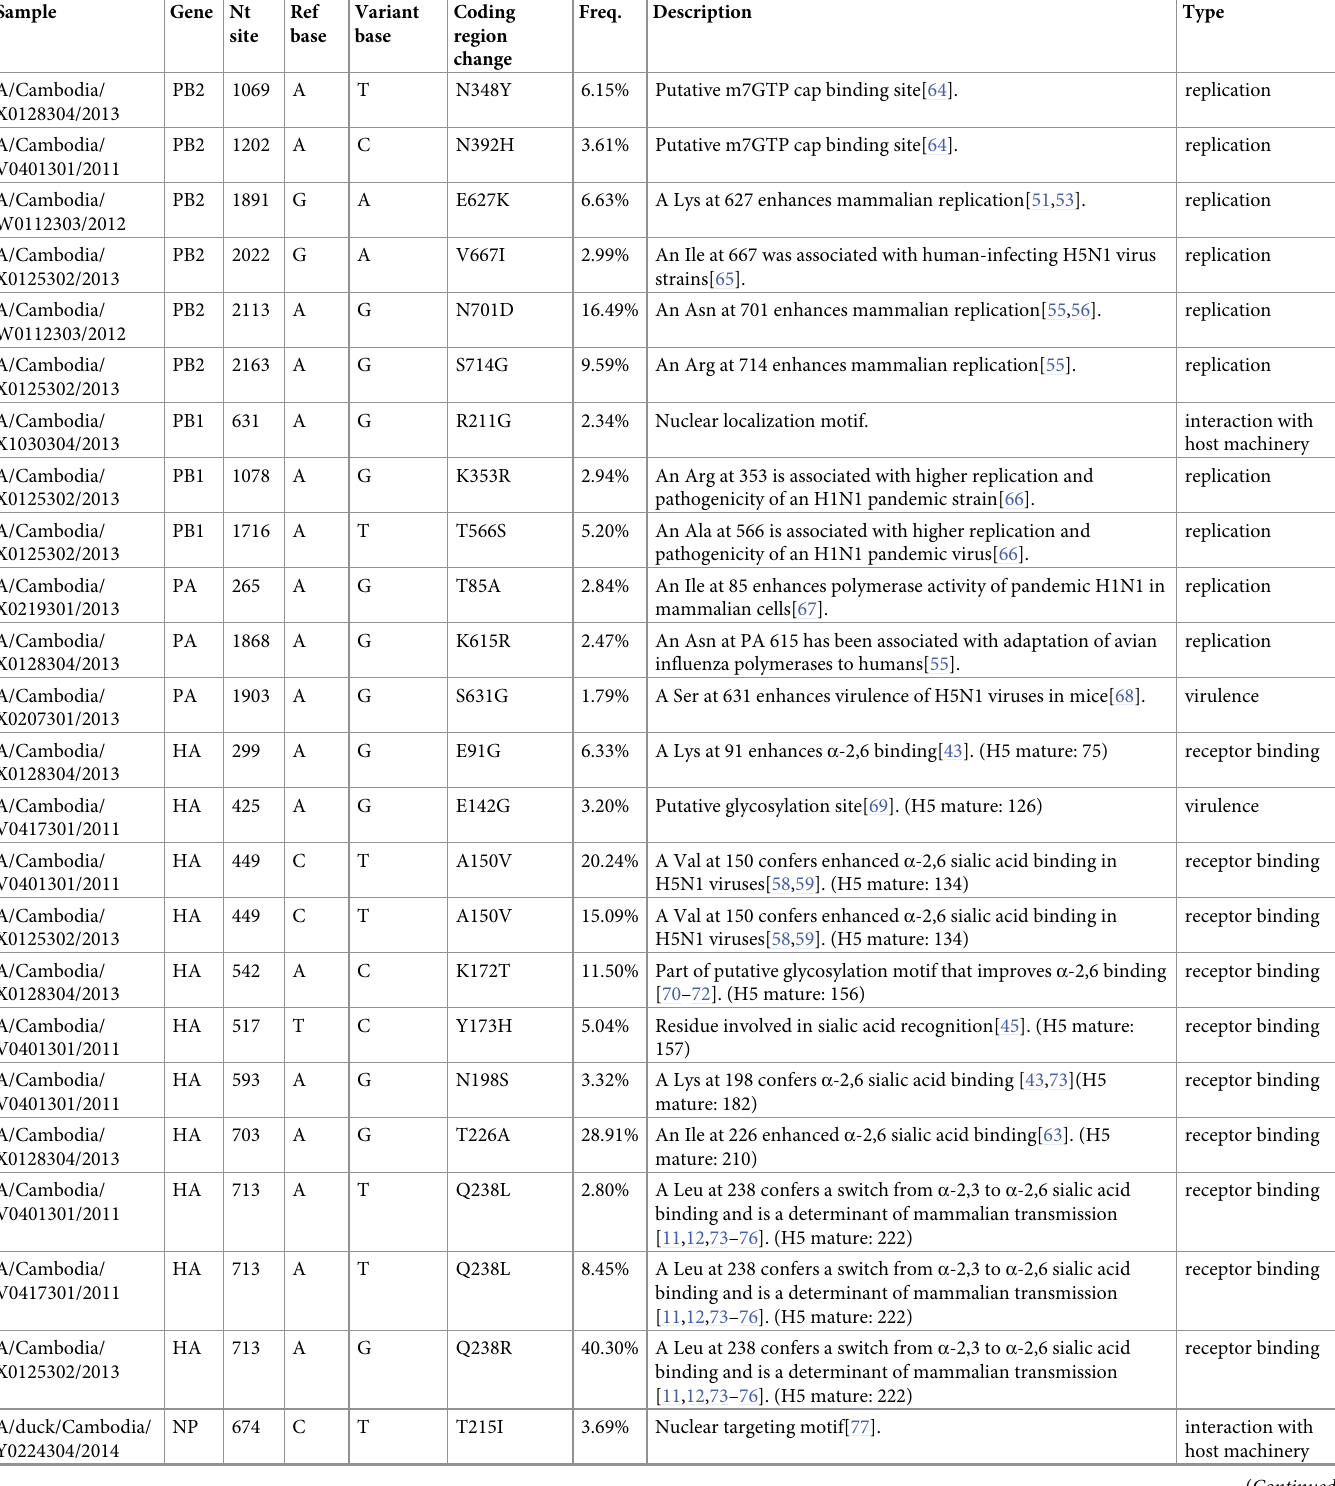
Table 3. Mutations identified at functionally relevant